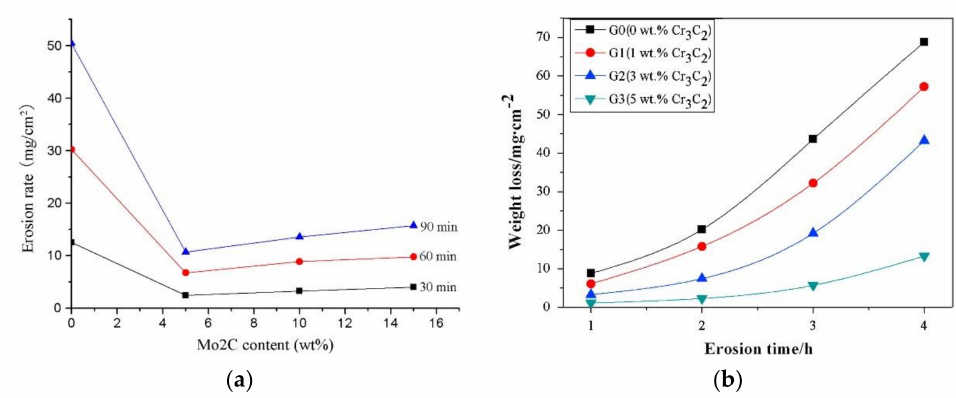
Figure 17. Erosion rate of TiC 0 . 7 N 0.3 - 15 wt% Ni cermets as the function of Mo 2 C content ( a ) [102] and Cr 3 C 2 addition to TiC 0.7 N 0.3 -10 wt% Mo 2 C-15 wt% Ni cermets ( b )